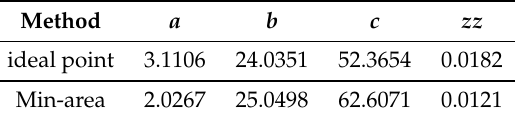
Table 9. n = 39 (confidence level is